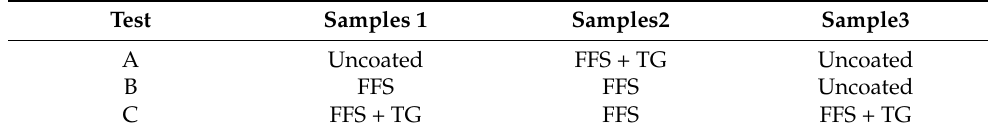
Table 1. Triangle sensory evaluation design of uncoated and coated